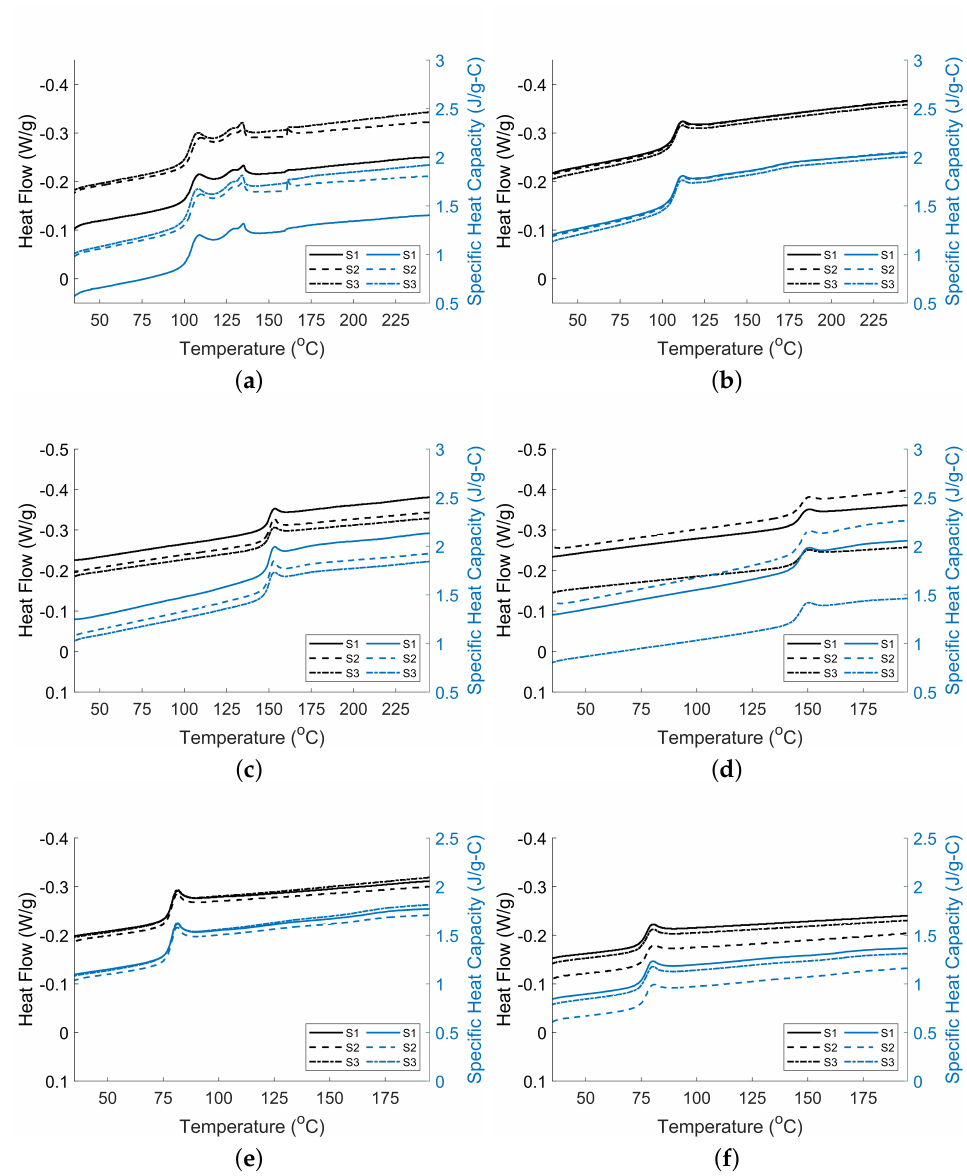
Figure 7. Heat flow (left y -axis) and heat capacity (right y -axis) of ( a ) ABS; ( b ) CF/ABS; ( c ) PC; ( d ) CF/PC; ( e ) PETG; and ( f ) GF/PETG. S1, S2, and S3 correspond to sample 1, sample 2, and sample 3,